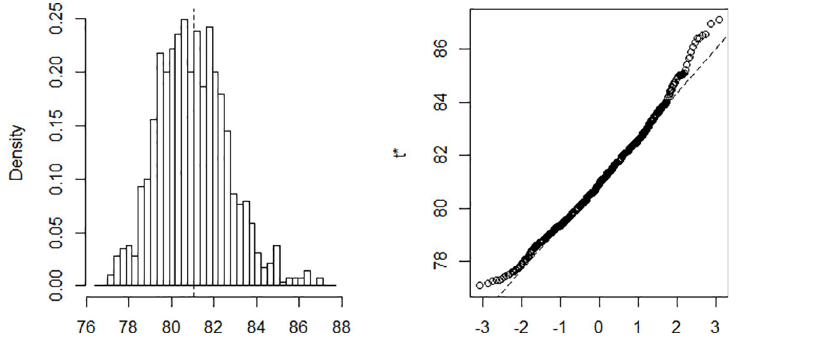
Fig 6. Bootstrap distribution of the number of days.